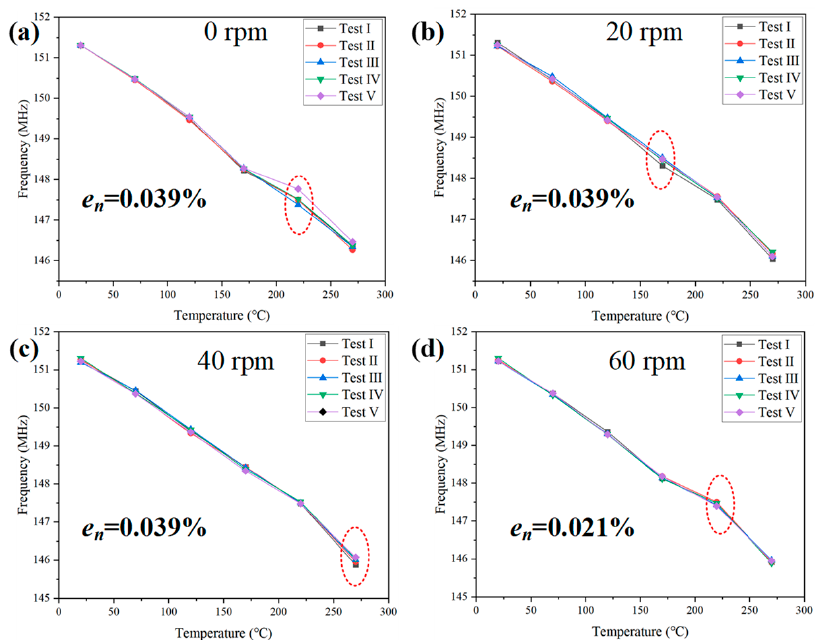
Figure 10. Repeatability of the wireless LC conformal temperature sensor at different rotational speeds. ( a ) 0 rpm; ( b ) 20 rpm; ( c ) 40 rpm; ( d ) 60 rpm.